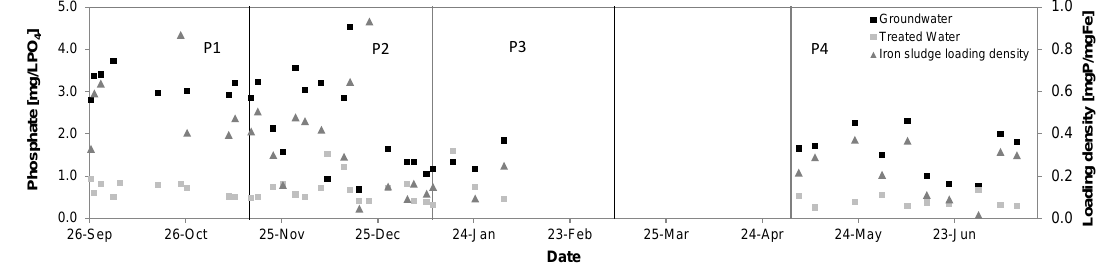
Figure 13. Phosphate removal performance of the Kalyani pilot system, September 2016–July 2017. Considering a surface site loading density of 0.9 mol sites/molFe [27] an average P removal of 0.6 mgP/L (19 µM) and an average iron removal 5.3 mg/L (95 µM), the loading densities averaged to 0.11 mgP/mgFe and the phosphate occupied about 20% of the adsorptive sites of the iron sludge, which is in agreement with the results stated in [26]. Figures 14 and 15 show the positive correlation between the loading density of arsenic (R 2 = 0.86, n = 49) and phosphate (R 2 = 0.86, n = 38) on iron hydroxide.